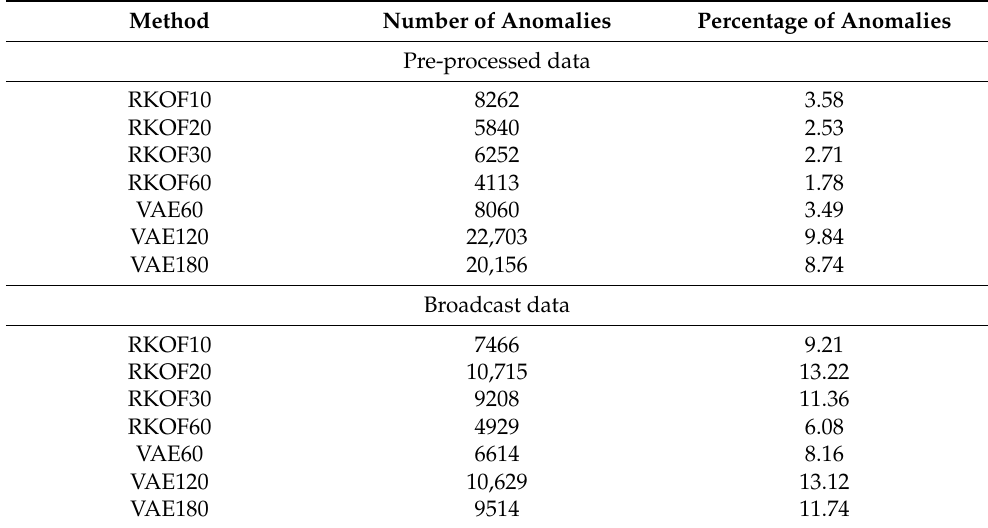
Table 1. A comparison of the number of samples recognized as anomalies and the percentage of actual